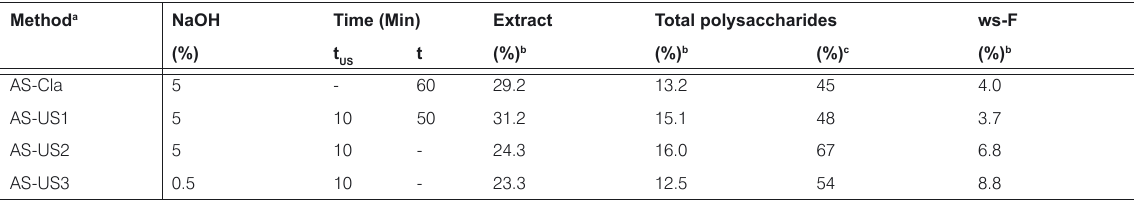
Table 4. Yields of extract, total extracted polysaccharides and their water-soluble fraction (ws-F) obtained from almond shells by classical (Cla) and ultrasound-assisted extraction (US)